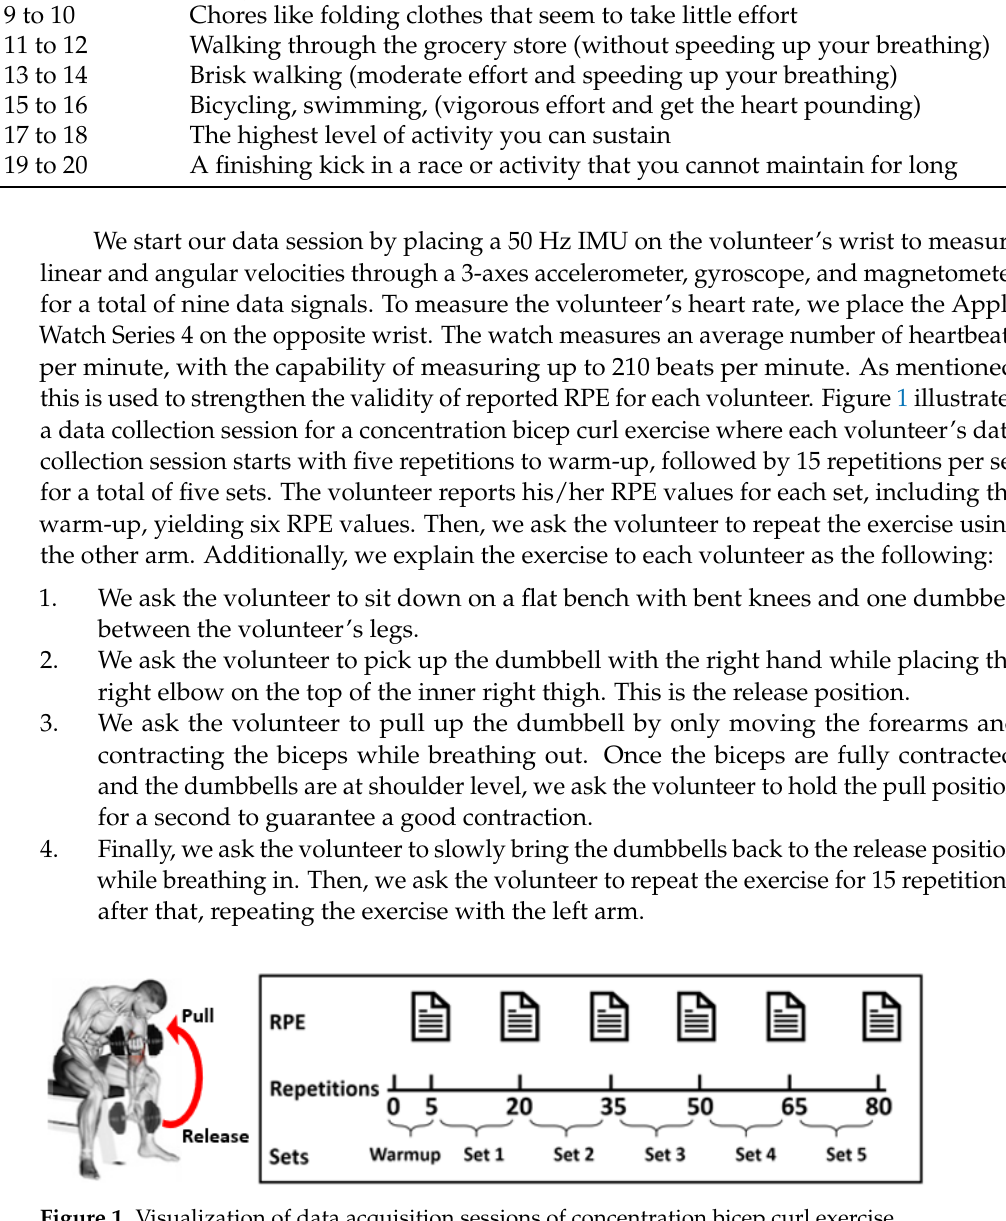
Figure 1. Visualization of data acquisition sessions of concentration bicep curl